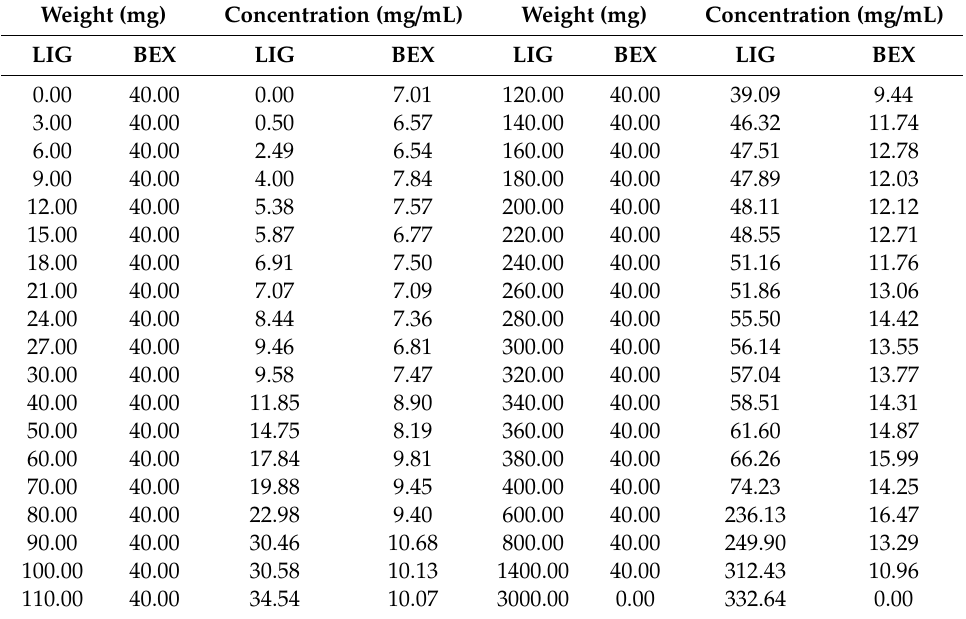
Table 1. Initial experimental data for system of 2bexarotene-ligustrazine (2BEX-LIG) ethanol at 20 °C. Weight (mg) Concentration (mg / mL)